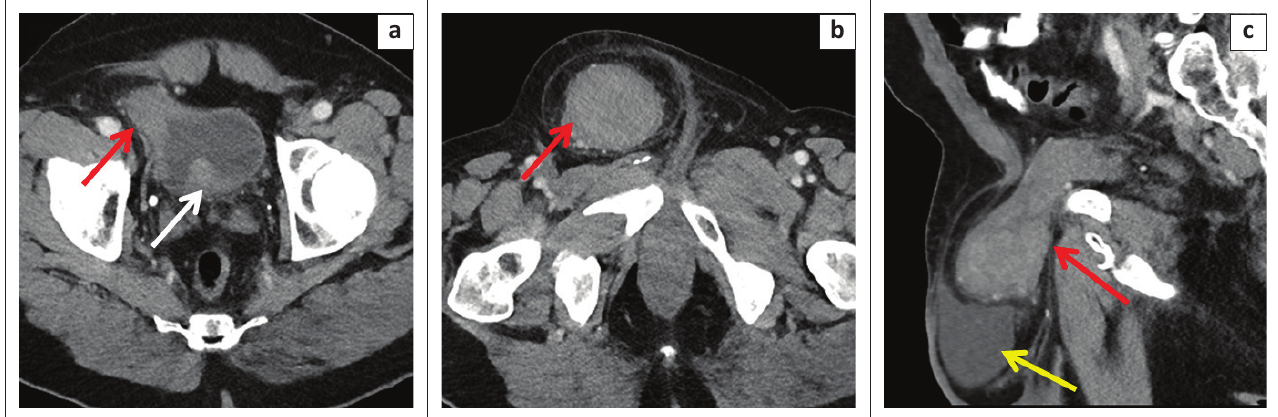
FIG URE 1: Computed tomography (CT) scan of the pelvis with intravenous contrast: (a) Axial CT image of the pelvis acquired during the portal venous phase demonstrates irregular thickening of the right anterolateral urinary bladder wall (red arrow) and an enlarged prostate bulging into the bladder base (white arrow). (b) Axial and (c) sagittal CT images of the inguinal region reveal a heterogeneous, enhancing soft tissue mass in the right inguinal canal, inseparable from the right anterolateral aspect of the urinary bladder wall (red arrow). There is a moderately sized hydrocoele in the right scrotum (yellow arrow).